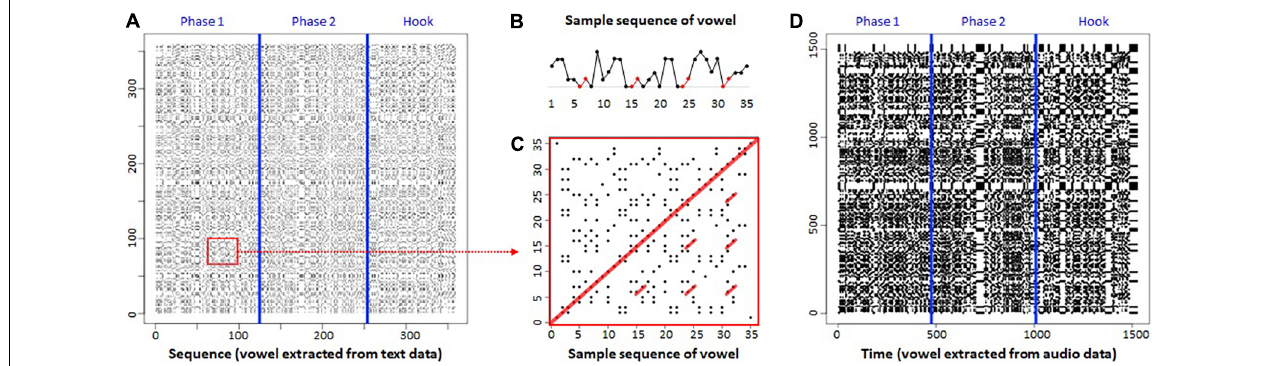
FIGURE 2 | Categorical recurrence plot (CaRP) of rap. (A) Standard CaRP. (B) Sample sequence of vowel. (C) Part of CaRP. (D) Proposed CaRP. Both x - and y -axes represent sequence or time series.